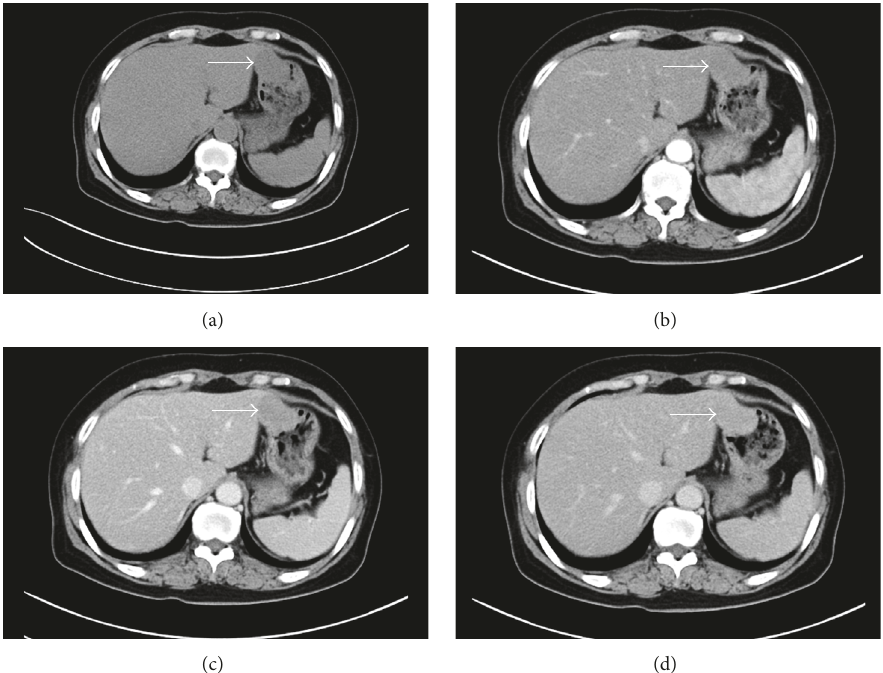
Figure 2: Computed tomography (CT) image of the gastric schwannoma. (a) An oval-shaped mass (white arrow) with a size of 43 × 32 mm was observed in the lesser curvature of the stomach, which exhibited a slightly low density on plain scanning CT imaging. (b) The CT value of the mass was about 38 HU before the injection of contrast medium. The mass showed delayed enhancement with a CT value of 53 HU on arterial-phase enhanced CT scanning. (c) The CT value of the mass was slightly increased (68HU) on portal venous-phase enhanced CT imaging. (d) The CT value of the mass was increased (78HU) on delayed enhanced CT scanning after a delay of 3